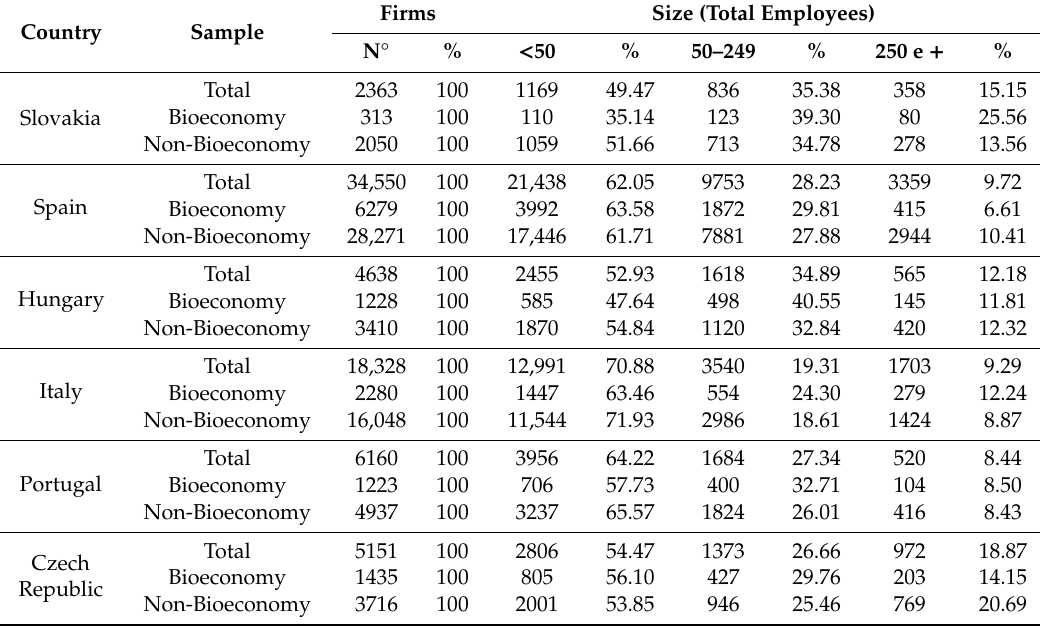
Table 1. Distribution of firms according to bioeconomy and non-bioeconomy and their distribution by size for total samples and